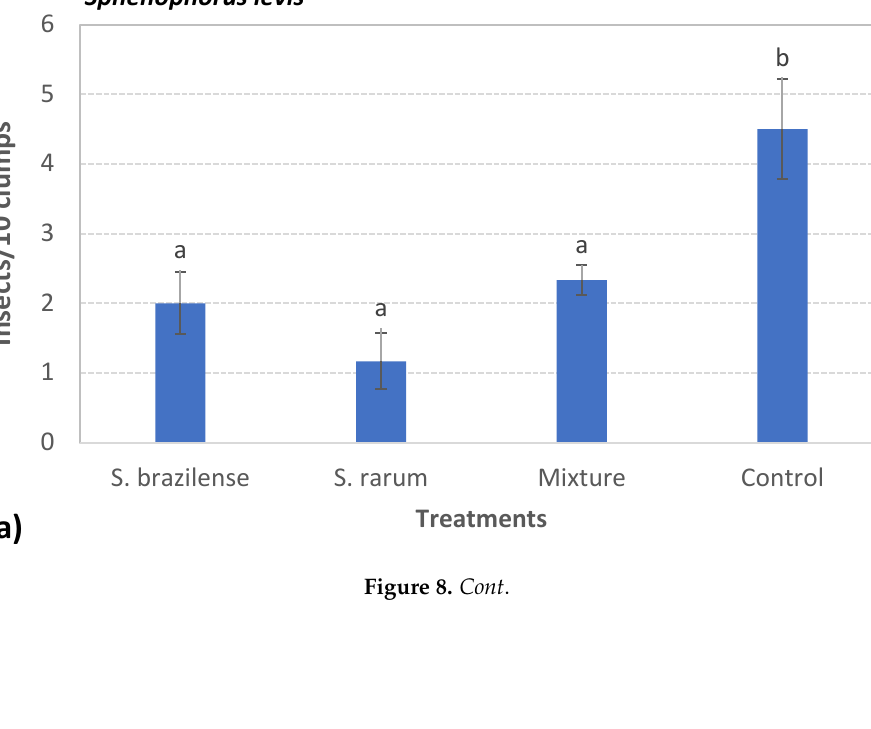
Figure 8. Populations of Sphenophorus levis (larvae + pupae + adults) ( a ) and Hyponeuma taltula (larvae) ( b ) in a sugarcane field, 21 days after the application of Steinernema rarum (2 × 10 8 IJs/ha), S. brazilense (2 × 10 8 IJs/ha), a mixture of both nematodes (total of 2 × 10 8 IJs/ha with each nematode contributing half) and control. Means followed by different letters in the columns differ significantly by the Tukey test ( p < 0.005). 3.5. Field test II—Rate effects